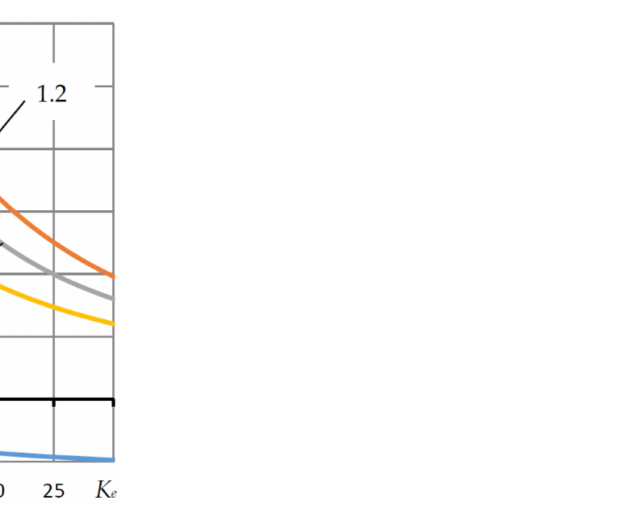
Figure 11. Dependences of the degree of stability η on the coefficient of elasticity K e at various values of the compression number σ .